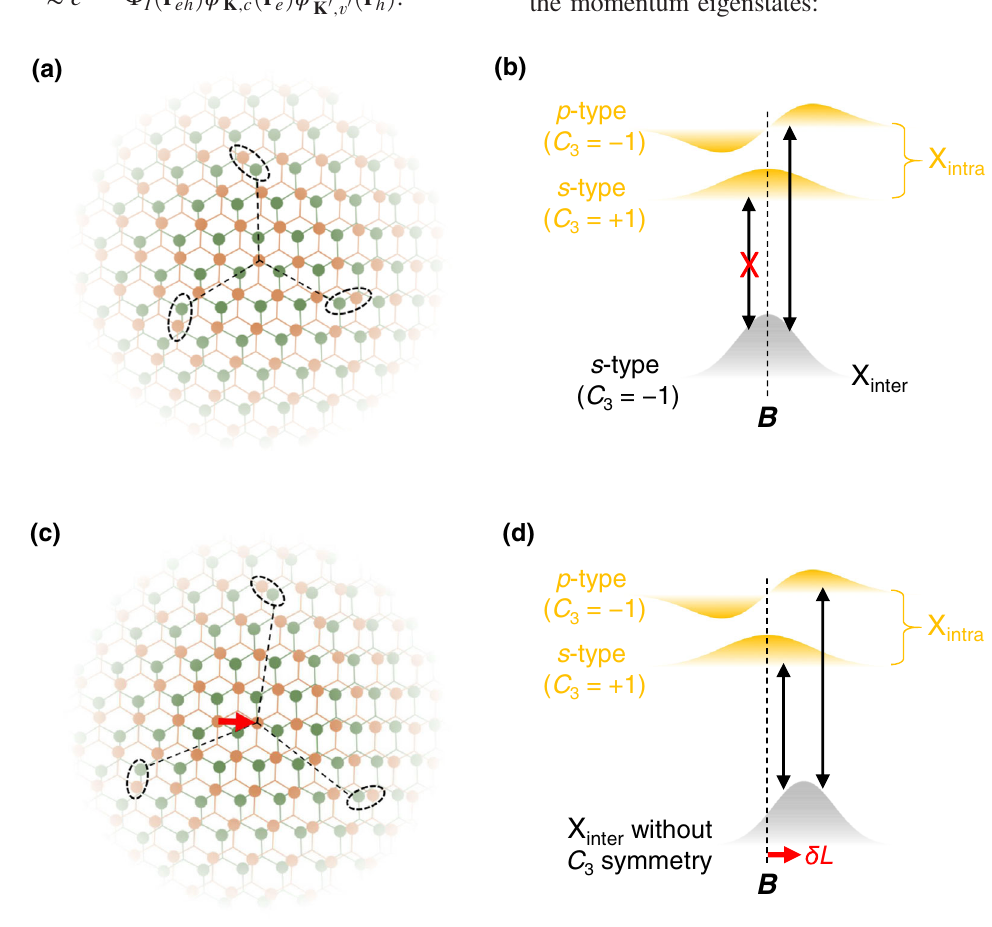
FIG. 5. (a) The bilayer atomic registry underlying an exciton wave packet centered at B , with a spread out determined by the c.m. envelope function as well as the relative motion. Each orange (green) dot denotes a metal atom d orbital in the upper (lower) layer, which ð r Þ = ψ ð r Þ . The three circled areas are related by ˆ C is the main constituent of the band edge Bloch function ψ K K 0 ;v 0 3 rotation, and the ;c e h ˆ C 3 symmetric. (b) The exciton wave packet centered at B . The wave packet is primarily an X whole wave packet is with the s -type inter ˆ ˆ C 3 symmetry of the trapping site, the wave function is an eigenfunction of C 3 , and its eigenvalue ( C 3 ¼ − 1 ) envelope. With the corresponds to the circular polarization ( σ − ) of the emission. Because of the perturbative interlayer coupling (vertical double arrows), the wave packet also contains a p -type envelope X component with C 3 ¼ − 1 . X with an s -type envelope has C 3 ¼ þ 1 , emits with intra intra σ þ polarization instead, and, therefore, is not allowed in the wave packet by the ˆ C 3 symmetry. (c) The atomic registry underlying an exciton wave packet slightly displaced from B , with the red arrow denoting the displacement vector. The three circled areas are no longer ˆ ˆ C 3 symmetric. (d) The exciton wave packet with a small displacement from B . As the C 3 rotation; thus, the wave packet is not related by ˆ C 3 symmetry is lifted, both the p - and s -type envelope X components are allowed in the wave packet wave restriction imposed by the intra function. In (b) and (d), gray denotes the envelope function of the primary X component, and yellow denotes that of X . The latter inter intra can have only a small contribution in the ground state wave function, as they are far detuned in